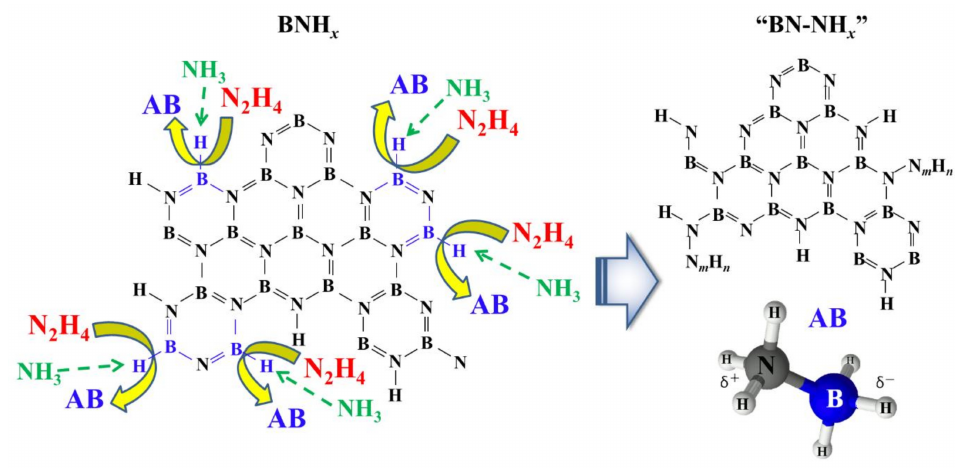
Figure 5. Conversion model of AB from BNH x by the N 2 H 4 / NH 3